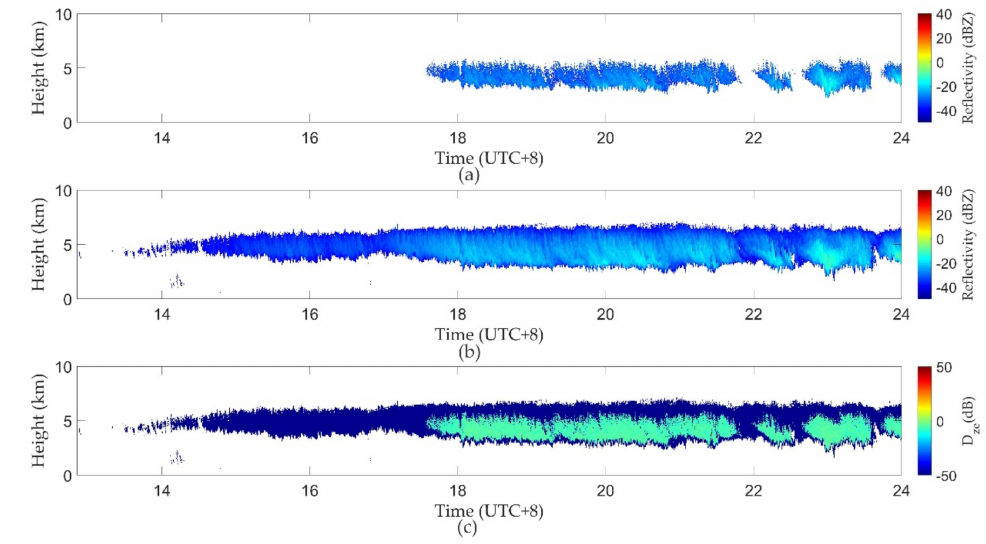
Figure 12. The reflectivity and its difference measured by the Ka-band radar and W-band radar on 19 February 2020: ( a ) Z e from the Ka-band radar; ( b ) Z e from the W-band radar; and ( c ) the D ze .